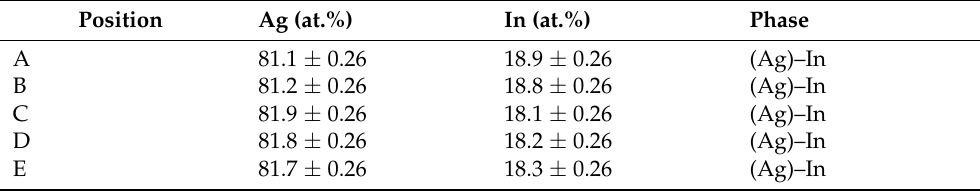
Figure 6. XRD patterns of the Ag–In alloy powders. Table 1. Composition determined using EDS at the positions indicated in Figure